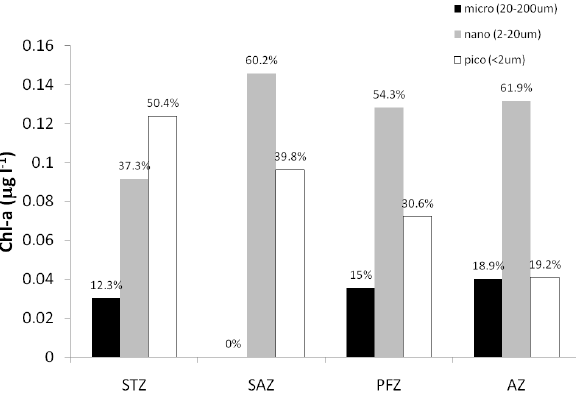
Figure 4. Size fractionated chl-a of surface samples in each region along the BGH cruise track. Bars indicate microphytoplankton (20 – 200 µm) given in black, nanophytoplankton (2 – 20 µm in grey and picophytoplankton (< 2 µm) in the white. Percentage of the total is presented at the top of each bar. It shows the decreasing contribution of picophytoplankton from north to south along the cruise track. Latitudes for the different zones are STZ (34 – 42.2 o S), SAZ (42.2 – 44.2 o S), PFZ (42.2 – 50.1 o S) and the AZ (50.1 – 57.5 o S).